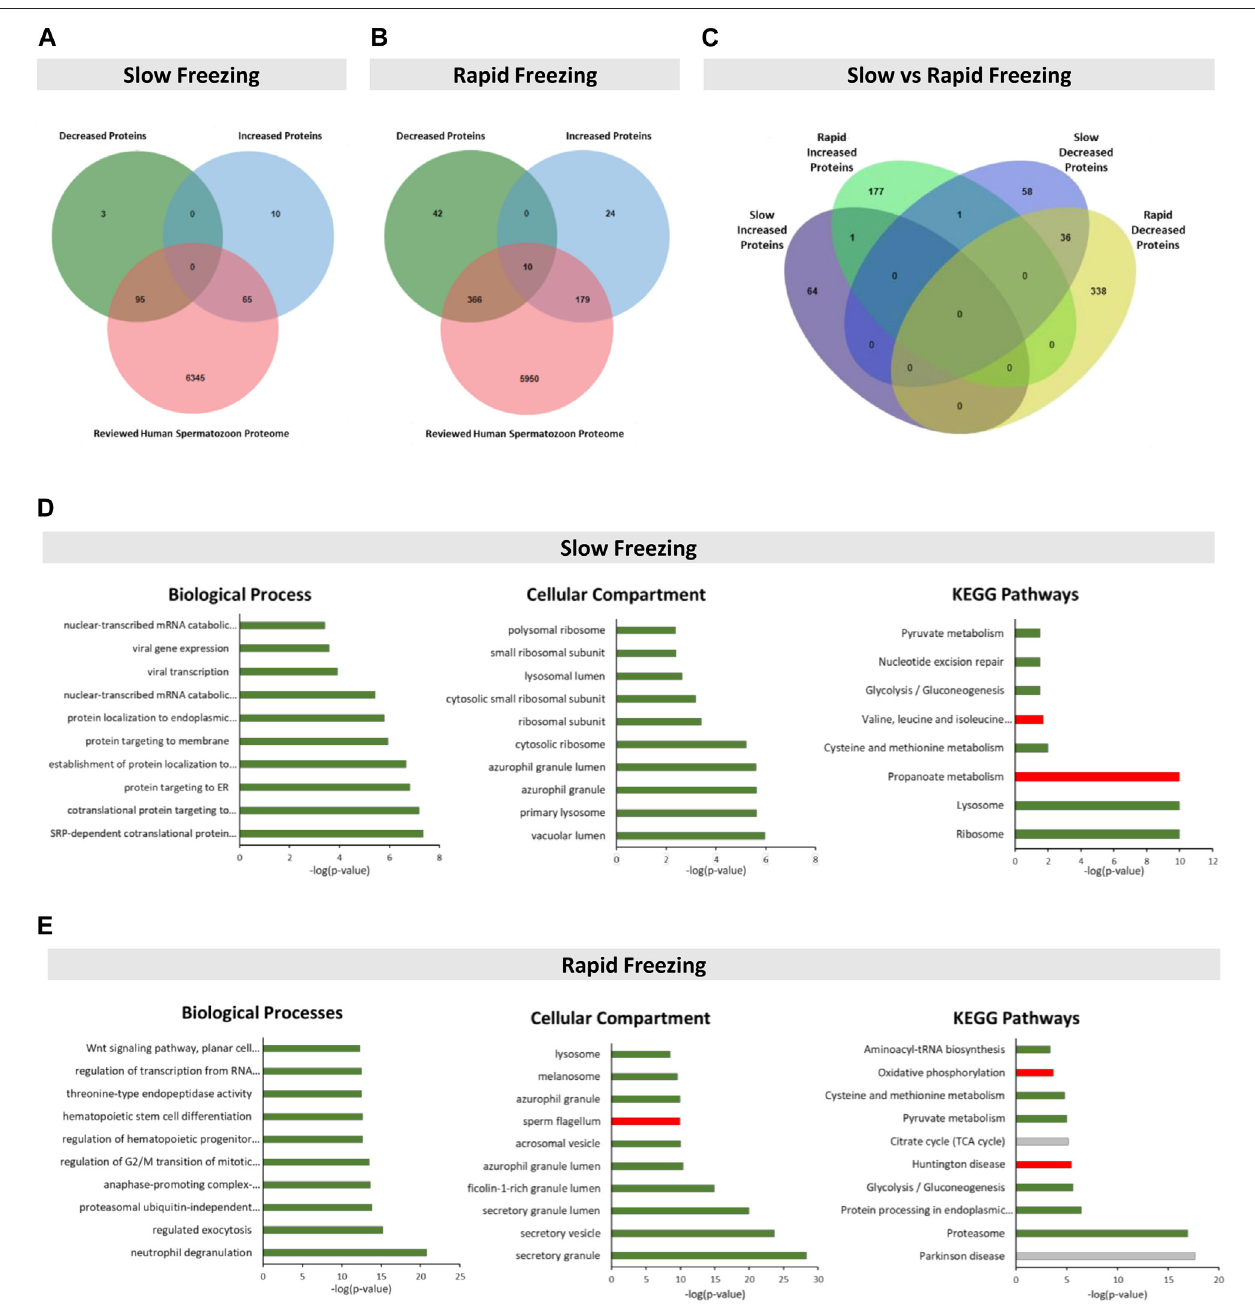
FIGURE 1 | Identi fi cation and enrichment analysis of the DEPs in slow and rapid freezing groups. (A,B) Venn ’ s diagram illustrates the cross-comparison performed between DEPs of each freezing group and the reviewed human spermatozoon proteome. For the subsequent analyses, only DEPs reviewed and previously described in human spermatozoon were considered. In Venn ’ s diagram of the rapid freezing group (B) , the 10 DEPs that were described as increased and decreased were not considered. (C) Venn ’ s diagram shows the common DEPs between slow and rapid freezing groups (D,E) Top 10 signi fi cant terms for biological processes, cellular components, and KEGG pathways related with DEPs of slow and rapid freezing groups, respectively. Enrichment analyses were performed using the ClueGO plugin through Cytoscape. In each graph, the bar color represents a speci fi c association as follows: green for decreased proteins; red for increased proteins; and grey for non-speci fi c associations. The signi fi cant terms were identi fi ed by Bonferroni ’ s step- down corrected p -value ( p < 0.01).